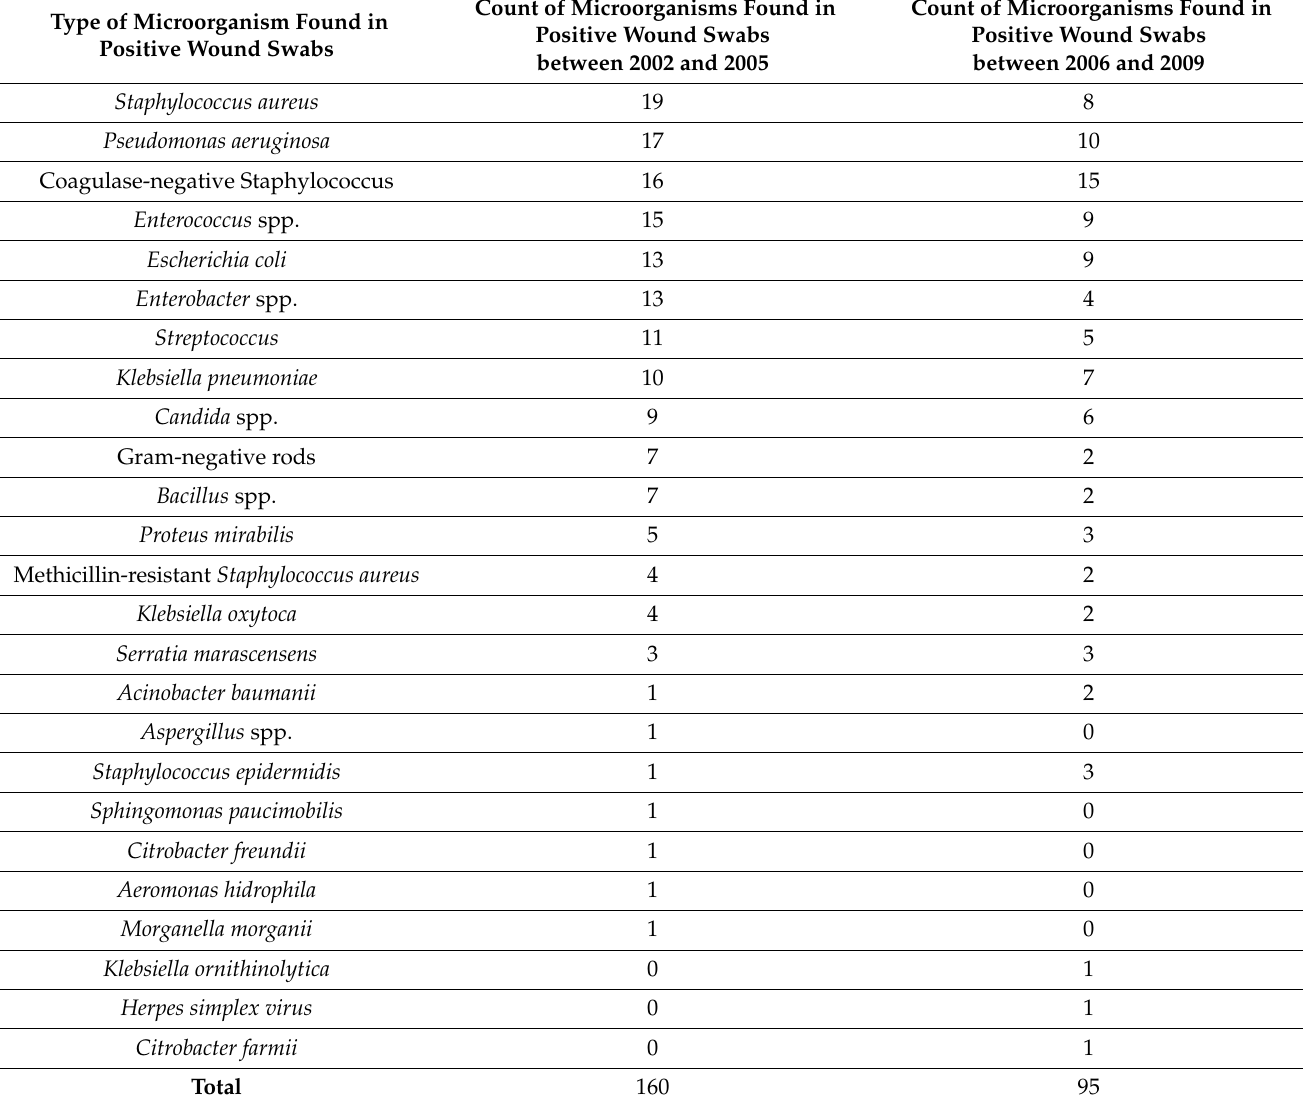
Table 3. The presented table gives an overview of the kinds of microorganisms found in positive wound swabs and their absolute count in positive wound swabs in the timespans of 2002 to 2005 and 2006 to